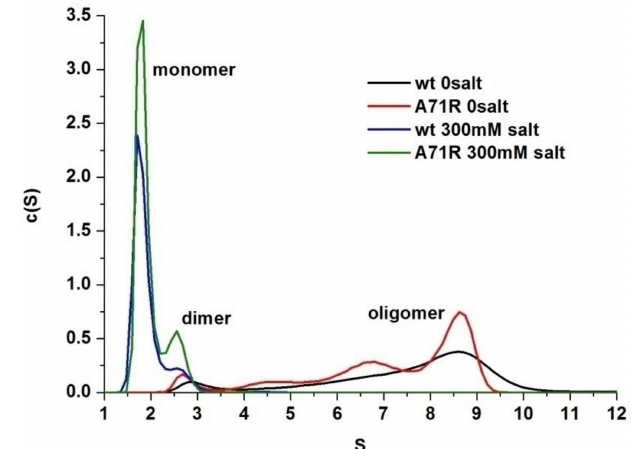
Figure 6. Overlay of sedimentation profiles of AcSpN and its A71R mutant at pH 7 and in the presence and absence of